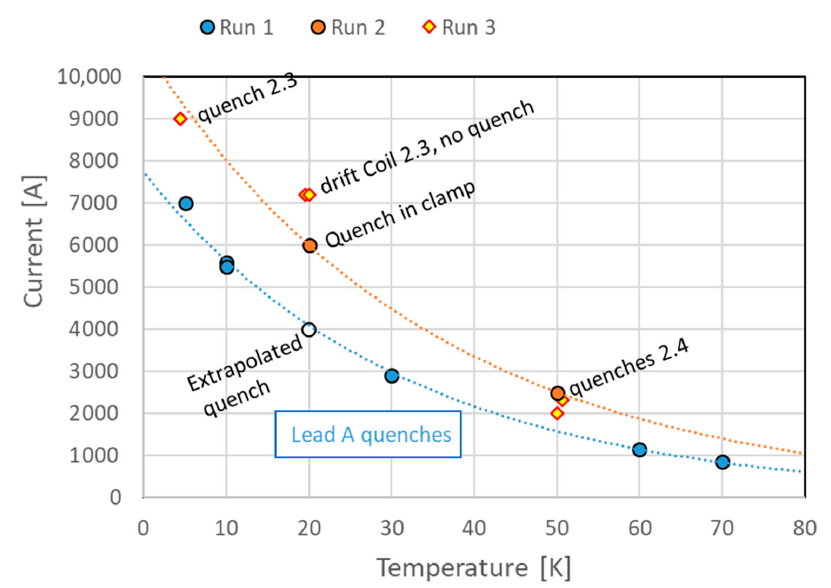
Figure 25. First powering campaign of the second AB dipole, FeatherM2.3-4, in terms of maximum current vs. operating temperature. Unpublished data CERN edms n. 2383644, by courtesy of G. de Rijk and G. Willering CERN.